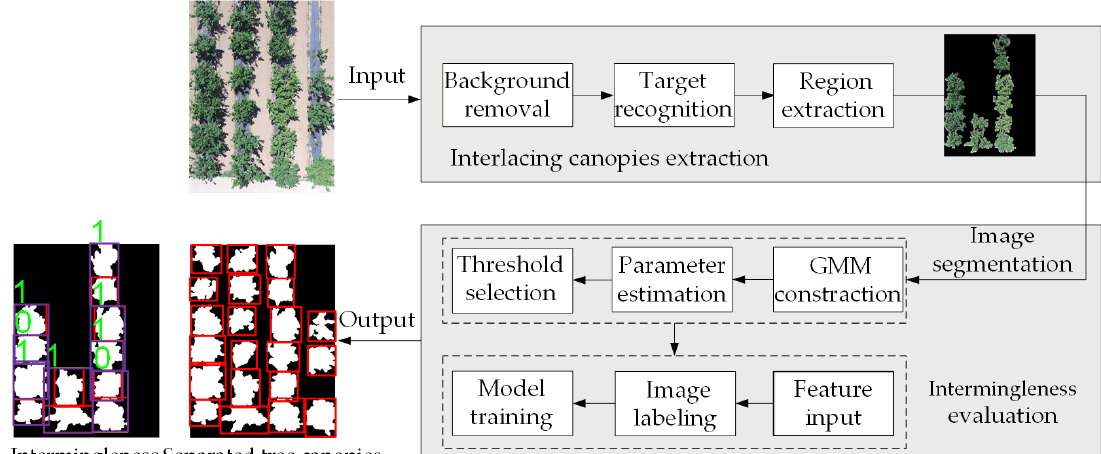
Figure 3. Overall flowchart of the proposed method. The input image is the original image, and the output image is the result of segmentation and evaluation of the canopy image: the extracted trees are enclosed within the red boxes for better illustration; the Extreme Gradient Boosting (XGBoost) classification model output will be 1 for the greatly intermingling canopies or 0 for the slightly intermingling canopies.